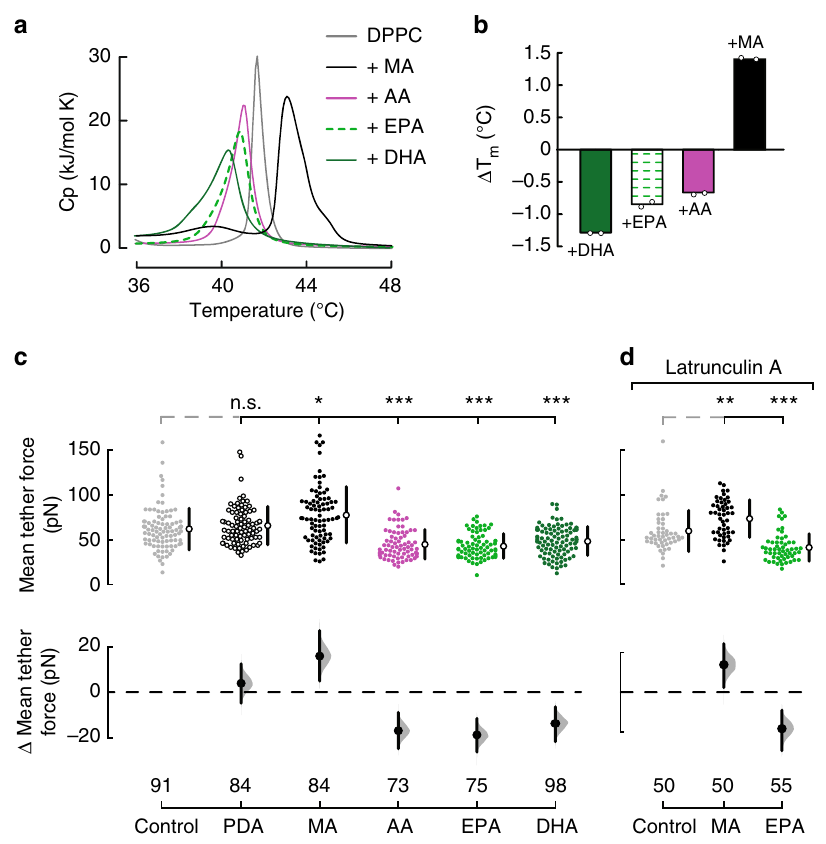
Fig. 3 Dietary fatty acids alter membrane fl uidity in N2A cells. a Representative thermotropic characterization of the DPPC/fatty acid systems using DSC: control ( T m = 41.68 °C), MA (43.08 °C), AA (41.04 °C), EPA (40.85 °C), and DHA (40.40 °C). b Effects of DPPC/fatty acids on melting temperatures ( Δ T m ) with respect to DPPC membranes. Experiments were performed from two independent preparations. c Estimation plot with all tether force data points presented as a swarmplot for control, pentadecanoic acid (PDA), MA, AA, EPA, and DHA (100 µ M)-treated N2A cells. d Estimation plot with all tether force data points presented as a swarmplot for latrunculin A (1 µ M; 1 h)-treated N2A control cells and supplemented with MA (100 μ M) or EPA (100 μ M). Bootstraps with 99.9% con fi dence interval and a comparison with the mean of the control group are displayed to the right and bottom of the raw data, respectively. Kruskal – Wallis and Dunn ’ s multiple comparisons test. Asterisks indicate values signi fi cantly different from control ( ∗∗∗ p < 0.001, ∗∗ p < 0.01, and ∗ p < 0.05) and n.s. indicates not signi fi cantly different from the control. n is denoted above the x